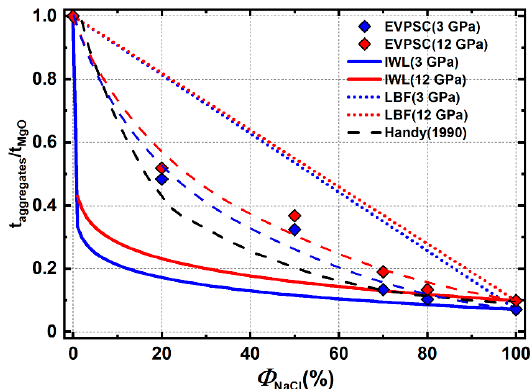
Figure 18. Normalized aggregate stress under varying phase proportions. Colored diamonds are modeling results from this study. Colored dash lines are guides for the eye based on these points. Solid and dotted lines are estimated stress under LBF and IWL microstructure. The black dash line are results from [3] with a yield contrast ~10.